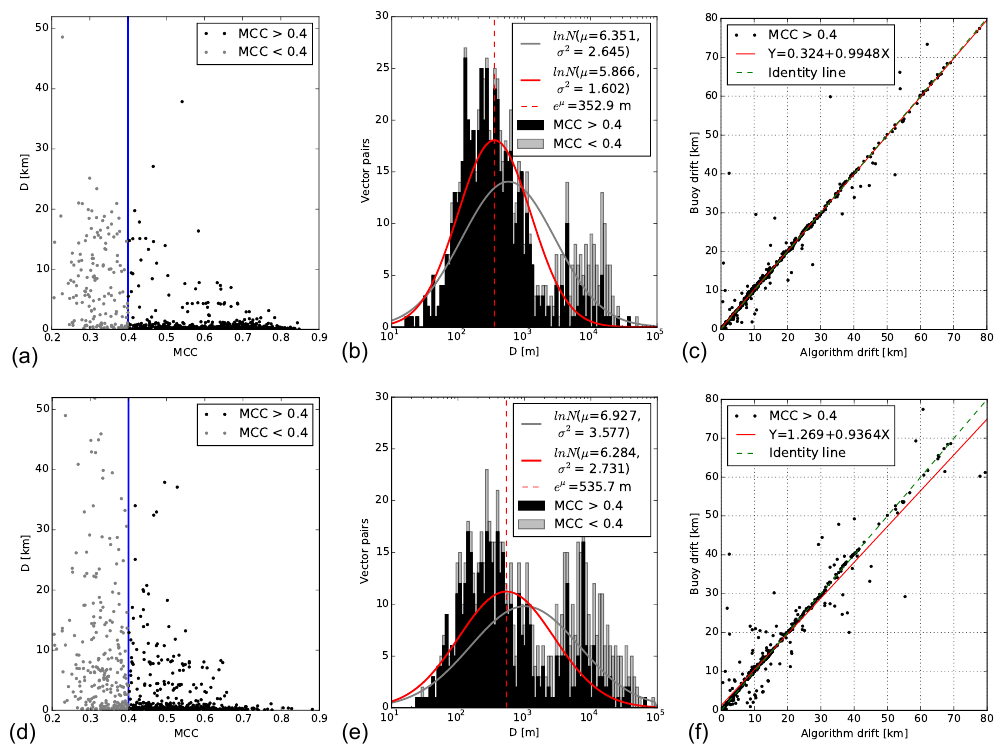
Figure 12. Calculated ice drift using recommended search restrictions compared to buoy GPS data using (a–c) HV and (d–f) HH polar- isation. Light grey represents vectors with maximum cross-correlation values MCC < 0.4 and results after using the suggested threshold MCC min = 0.4 are shown in black. (a, d) MCC values against distance D (Eq. 15) between algorithm and buoy end position. The blue line indicates the recommended setting for MCC min = 0.4. (b, e) Logarithmic histogram of distance D with 100 bins between 10 and 10 5 m including two logarithmic normal distributions that were fitted to all results (grey) and to the filtered results with MCC > 0.4 (solid red line). (c, f) Comparison of drift distance derived from the algorithm against buoy displacement for the filtered results with MCC > 0.4. Table 1. Recommended parameter setting for sea ice drift retrieval from Sentinel-1 using the presented algorithm. Parameter Meaning Recommended setting [ σ 0 , σ 0 max ] (HH) Brightness boundaries for HH channel min